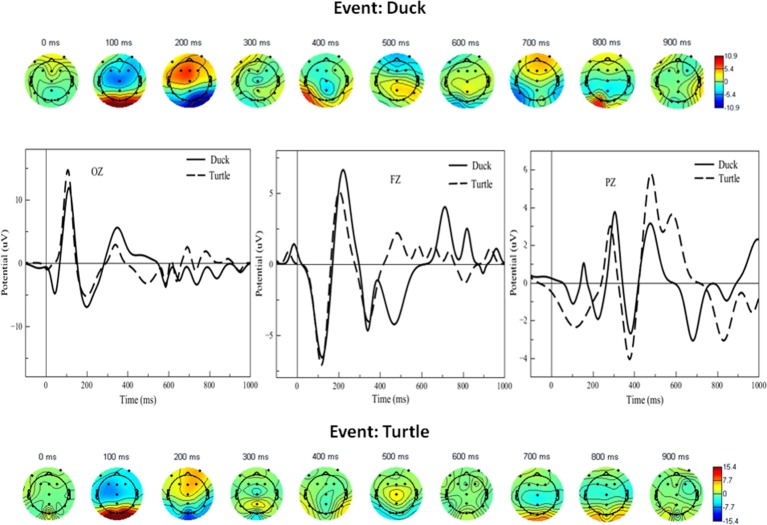
Bottom and top arrays: Scalp maps for selective attention task events (turtle, depicted with dashed lines, and duck, depicted with solid black lines). The graphs in the middle show ERP waveforms corresponding to the scalps at selected midline electrodes. Dark blue and red scalp areas represent significance at p < 0.05 in the Simes-Bonferroni corrected T-test band across the entire epoch (see text). We next focused our analysis on the two key proposed predictions. Figure 6B shows waveforms concurrent with the word-verification event for concrete and abstract sets of PPVT words, wherein the more concrete words included only items from the first set, and the more abstract included only items from the very last set successfully completed by each subject; given that the number of trials was reduced, the ERPs were smoothened to allow for a clearer evaluation of effects critical to this context. The most important and significant differences are highlighted in Figure 6C with gray frame boxes, for the site where the largest activation was detected through scalp maps, at the right occipital electrode (O2). As predicted, there was higher positive activation concurrently with concrete than with abstract words in the first 100 ms of the PPVT task [t(13) = 6.52; p < 0.0001]. Conversely, there was higher positive activation concurrently with abstract than with concrete words in the 750–850 ms interval [t(13) = 7.71; p < 0.0001].